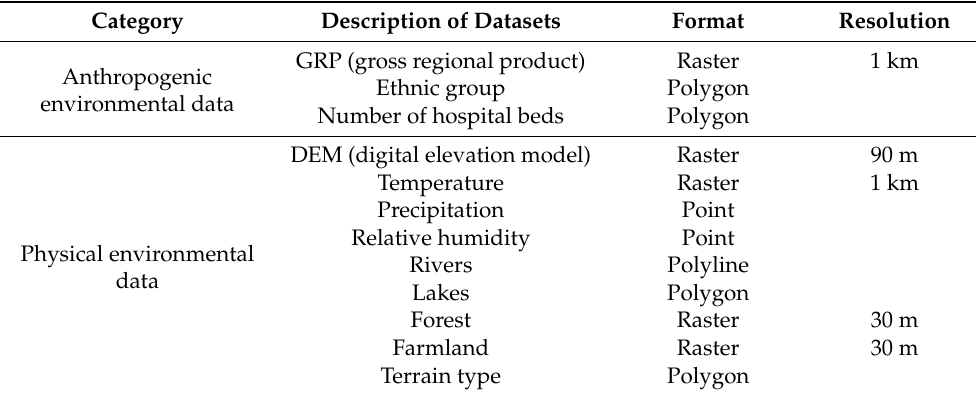
Table 1. Summary of environmental datasets used in this